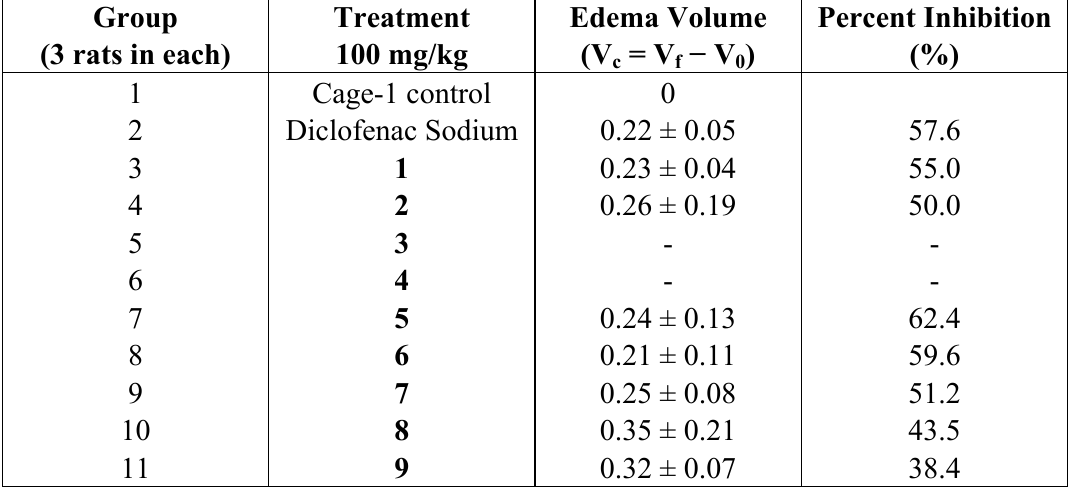
Table 3. Anti-inflammatory potential of compounds 1–9 in carrageen induced paw edema of rats.